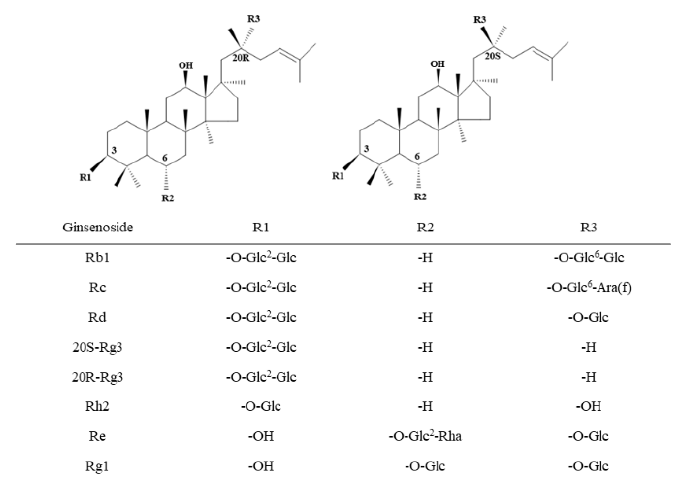
Figure 1. Structural formula of the ginsenoside (GS) monomer. The numerical superscript indicates the carbon on the glycosidic bond. Glc, glucose; Ara(f), arabinofuranose; Rha, rhamnose.